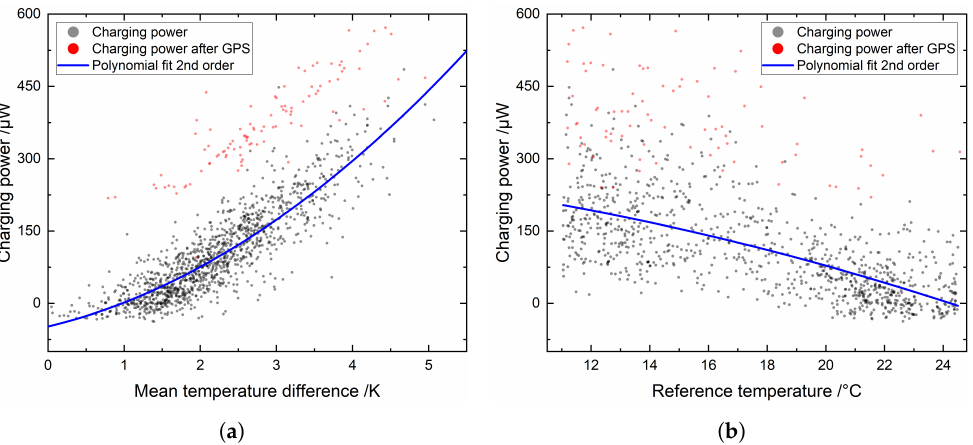
Figure 14. Charging power versus ambient temperature respectively the corresponding ∆ T at the TEG from the tracker of goat 1. The marked data are excluded as these are outliers recorded after using high current periphery such as GPS. ( a ) Charging power versus ∆ T TEG . ( b ) Charging power versus the ambient